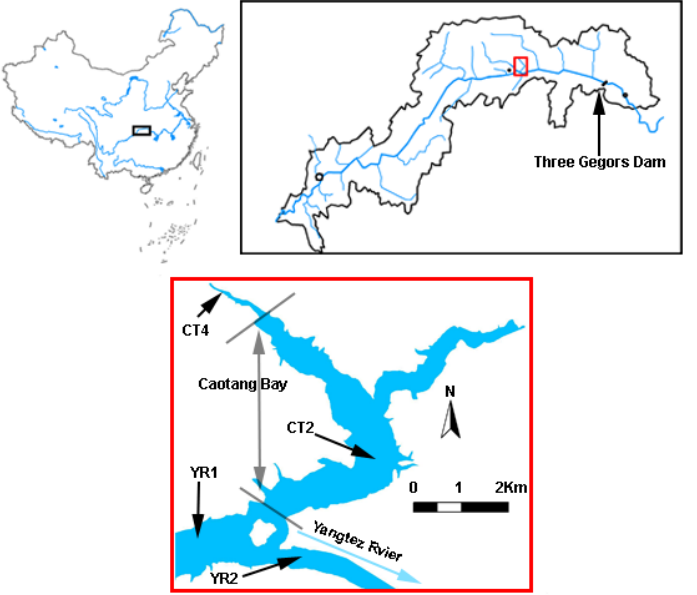
Figure 1. Study area and sampling sites. YR: Yangtze River.